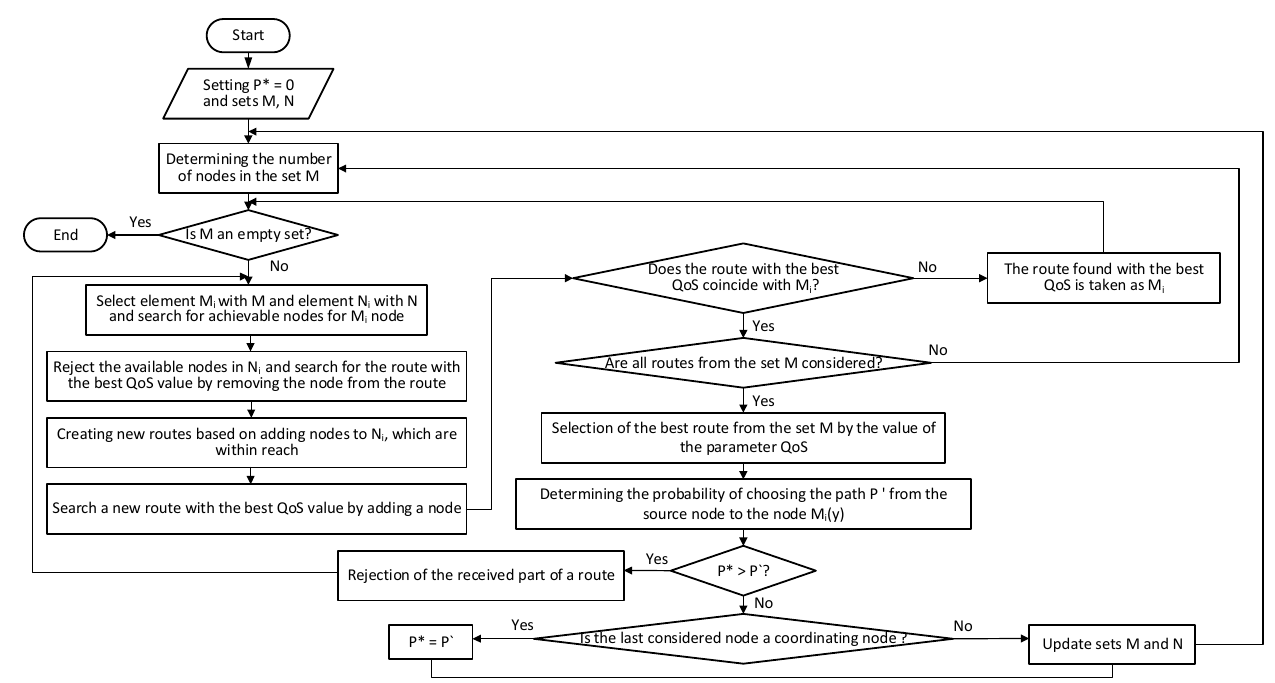
Figure 4. A generalized block diagram of the proposed routing method based on a combination of the developed ant algorithms and simulated annealing.